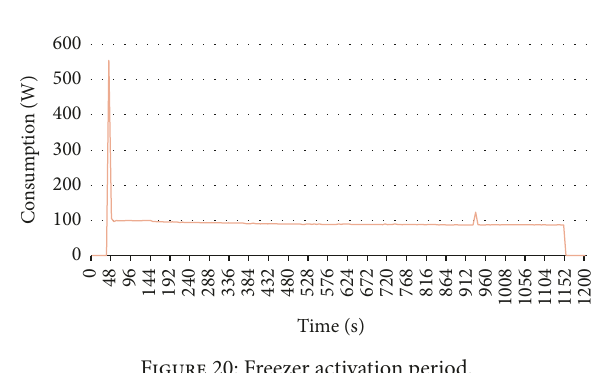
Figure 19: Electrical boiler activation period.